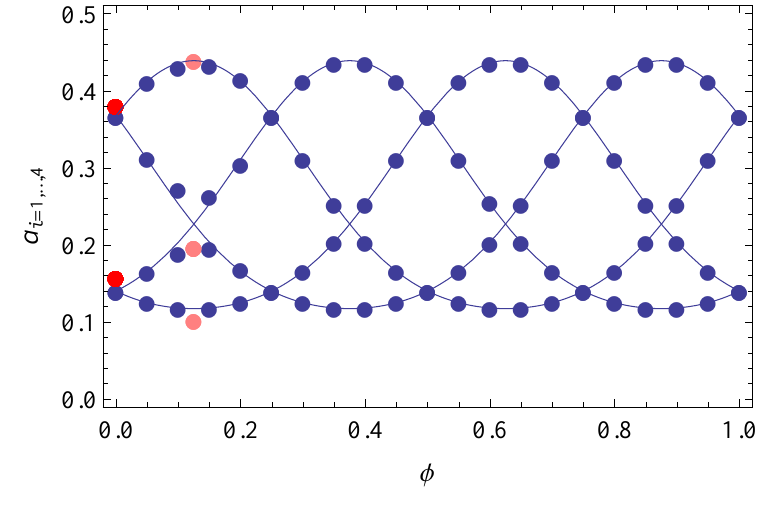
Figure 9: Various degenerate solutions for the CDW distortions a grable case ( λ = 2): numerical results (blue circles) and exact results (lines). Here = 0 → I = 6.321, q = 0.225. In the nonintegrable case ( λ ̸ = 2), p = 0.02, ξ = 1, ξ 4 0 the solutions are non degenerate and are shown by the pink points ( λ = 1.9) -the middle point is twice degenerate, and by the red points ( λ = 2.1) -the two points are twice degenerate, corresponding to the structures shown in Fig.